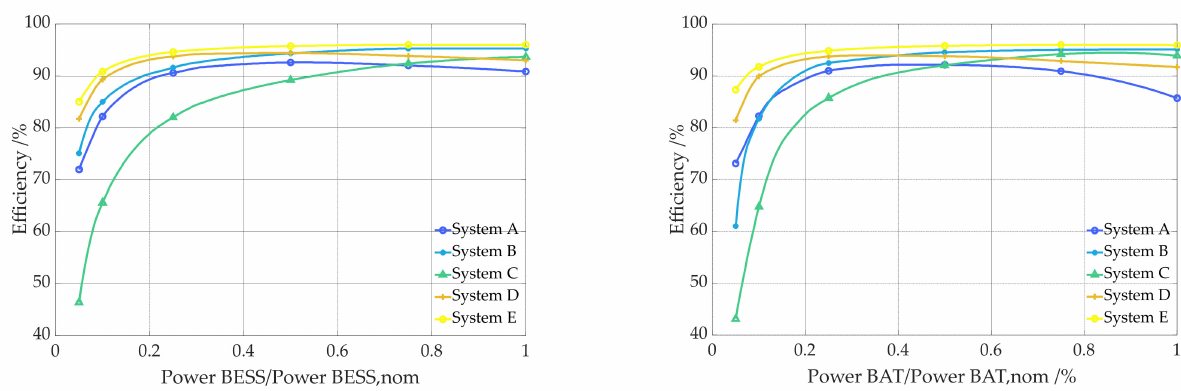
Figure 2. Efficiency of the power conversion pathways AC2BAT (battery charging— left ) and BAT2AC (battery discharging— right ) as a function of the output power, for 5 PV storage systems.